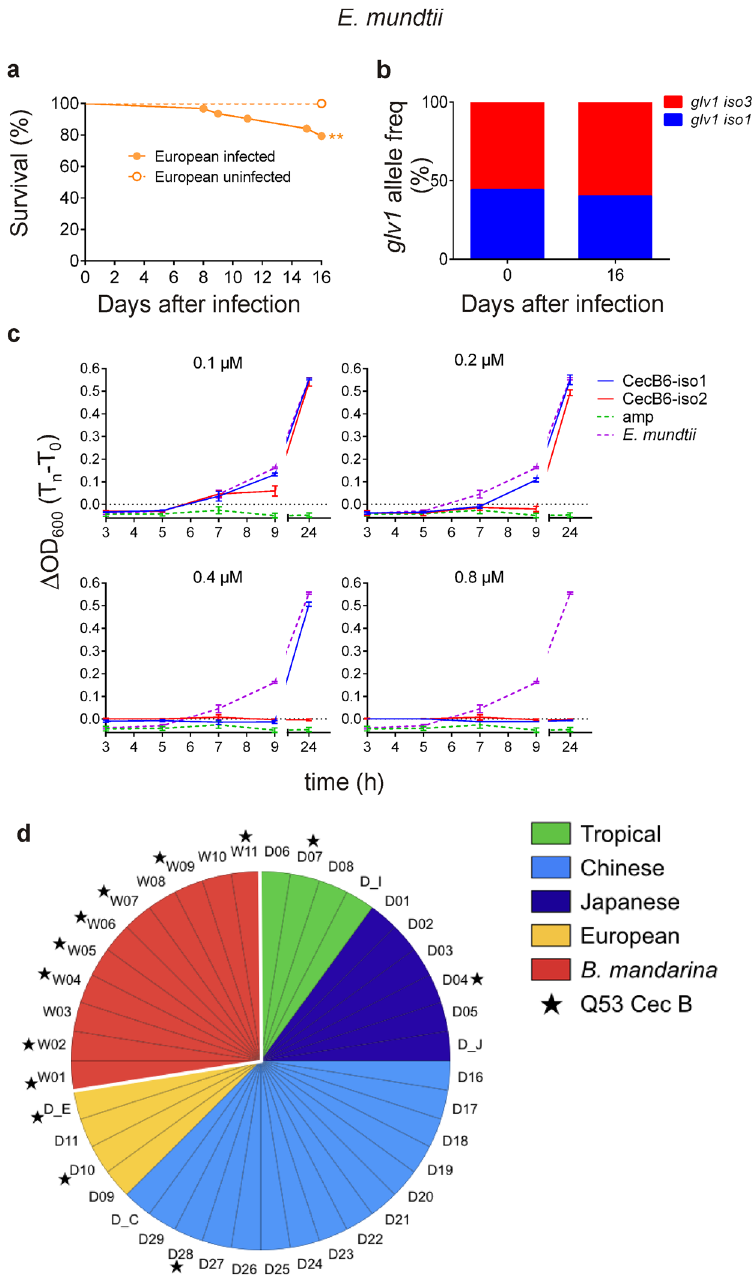
Figure 4. Contribution of B . mori Glv 1 and Cec B6 isoforms to the protection against E . mundtii . ( a ) Survival curves of sixty-three European larvae orally infected with E . mundtii and seventy uninfected controls ( ** p = 0.0013 in Mantel-Cox test). ( b ) glv 1 iso1 (blue) and glv 1 iso3 (red) allelic frequencies before E . mundtii infection (day 0) and in adult survivors (day 16). ( c ) MIC of E53 Cec B6 iso1 (blue) and Q53 Cec B6 iso2 (red) evaluated at 0.1, 0.2, 0.4 and 0.8 µ M against E . mundtii . Δ OD600 (T n -T 0 ; mean ± SEM): differences in OD 600 s obtained at time 0 (T 0 ) with those measured at different time points (T n : 3, 5, 7, 9, and 24 h). amp (green): negative control, bacterial growth in presence of ampicillin (50 µ g/ µ L). E . mundtii (purple): positive control, bacterial growth in culture medium. ( d ) Presence of the Q53 Cec B variant in B . mori and B . mandarina . W (red area): B . mandarina silkworms; D: B . mori domesticated silkworms. The strains of this work are indicated as: D_I (Indian), D_J (Japanese), D_C (Chinese), D_E (European); all the others derived from ref. 29. Tropical region: green; Japan: purple; China: light blue; Europe: